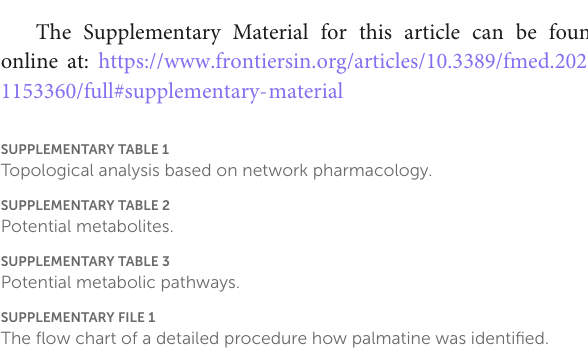
SUPPLEMENTARYFILE1 The flow chart of a detailed procedure how palmatine was